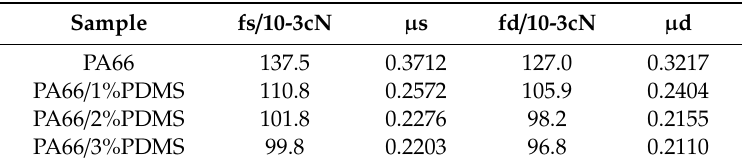
Table 2. Surface friction coefficient of the obtained fibers.